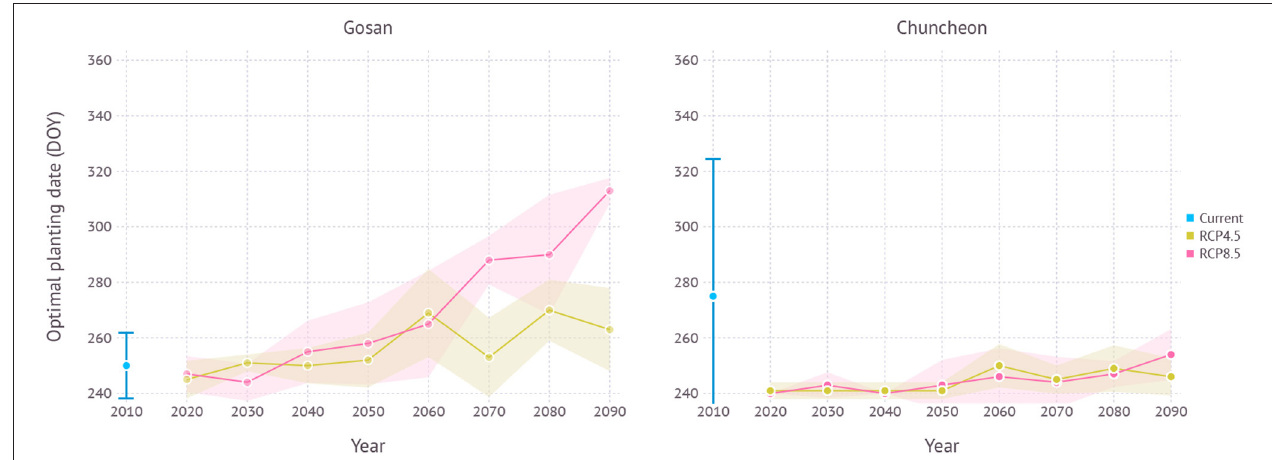
FIGURE 11 | Optimal planting dates estimated for each year under current and future climate projections in Gosan and Chuncheon. The year 2010 indicates simulation results with 30-years normal weather data from 1980–2010 representing current climate. For RCP scenarios, each year indicates a 10-year average, e.g., 2090 refers to 2090–2100. Error bar and shades represent a range of ± 1 SD from mean optimal planting date.